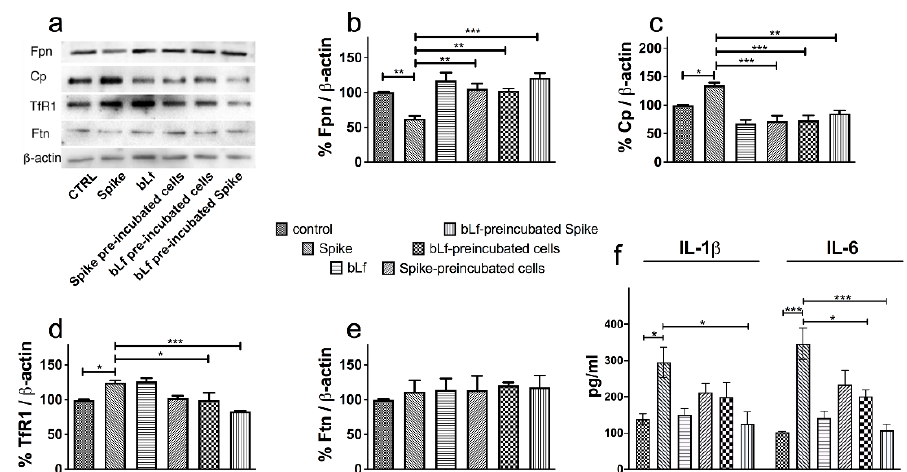
Figure 5. Protective effect of bovine lactoferrin (bLf) against iron and inflammatory disorders induced by SARS-CoV-2 Spike glycoprotein on THP-1 cells. Western blot ( a ) and densitometry analysis of ferroportin (Fpn) ( b ), membrane-bound ceruloplasmin (Cp) ( c ), transferrin receptor 1 (TfR1) ( d ) and ferritin (Ftn) ( e ) levels and ELISA quantitation of IL-1 β and IL-6 production ( f ) in THP-1 cells untreated or treated with 20 nM Spike glycoprotein in the absence or presence of 1.25 µ M bLf. See text for details. Error bars: standard error of the mean. Statistical significance is indicated as follows: *: p < 0.05; **: p < 0.01; ***: p < 0.001 (one-way ANOVA with post-hoc Tukey test).